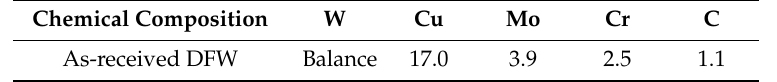
Table 1. Chemical composition of as-received double-forged pure tungsten (DFW) rod (10 − 3